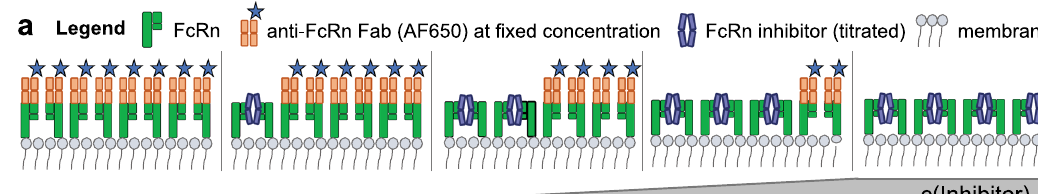
Fig. 3 | Binding of IgG-Fab regions to membrane-associated FcRn and cellular uptake of IgG1. a Schematic overview illustrating the principle of the surface competition assay to measure membrane-associated FcRn binding. b Histograms of a representative experiment comparing the binding of AF650-labeled anti-FcRn Fabto membrane-associatedFcRnexpressed onthesurfaceofHEK-FcRn-GFP cells when co-incubated with the indicated FcRn inhibitors (full-size IgG1 or Fc frag- ments) at pH 6.0 on ice at 4°C. Detection (AF650-labeled anti-FcRn Fab):inhibitor molar ratio at highest inhibitor concentration=1:25 (optimized to measure com- petition with MST-HN containing IgG1). c Anti-FcRn Fab-AF650 staining of cells plotted as percent gMFI in the presence of indicated inhibitors compared with untreatedcells. d Anti-FcRnFab-AF650stainingofcellsplottedasin( c ),butforWT IgG1 variants of different speci fi cities with indicated numbers of Fab or H435A